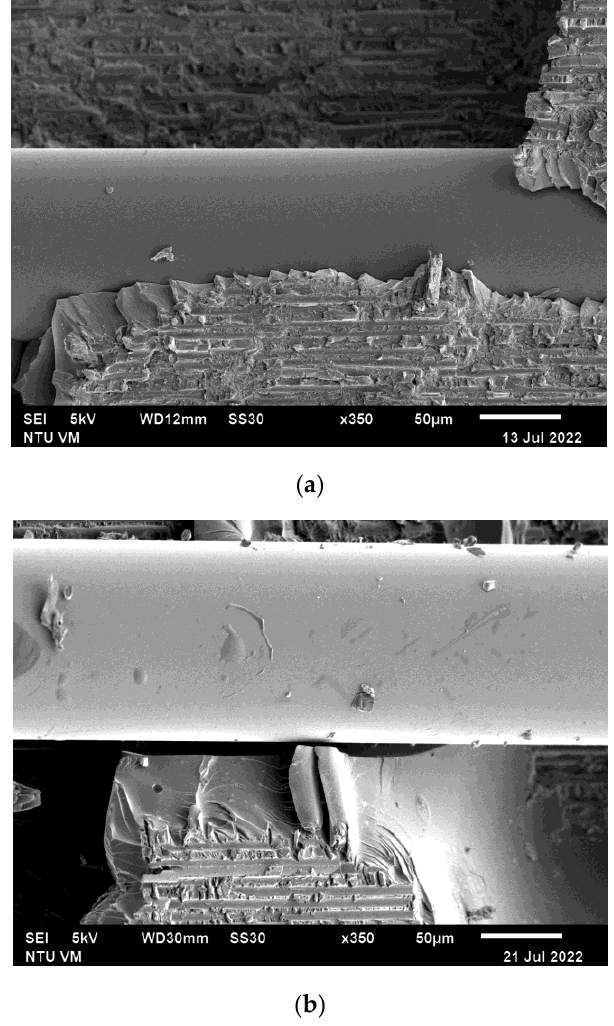
Figure 17. Typical SEM fractographs from two fatigue specimens showing ( a ) smooth optical fiber surface and ( b ) smooth optical fiber surface and secondary crack in adhesive.